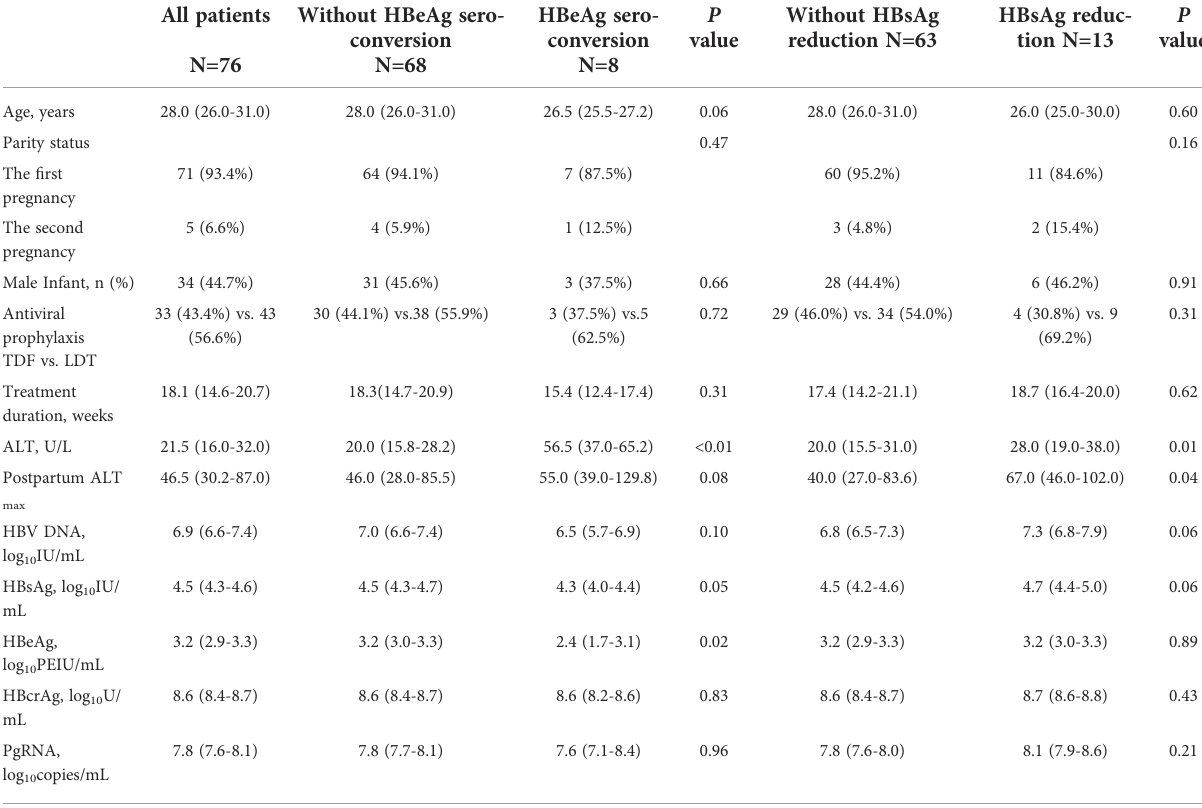
TABLE 1 Demographics and clinical characteristics of 76 pregnant CHB carriers with HBeAg positive at baseline. All